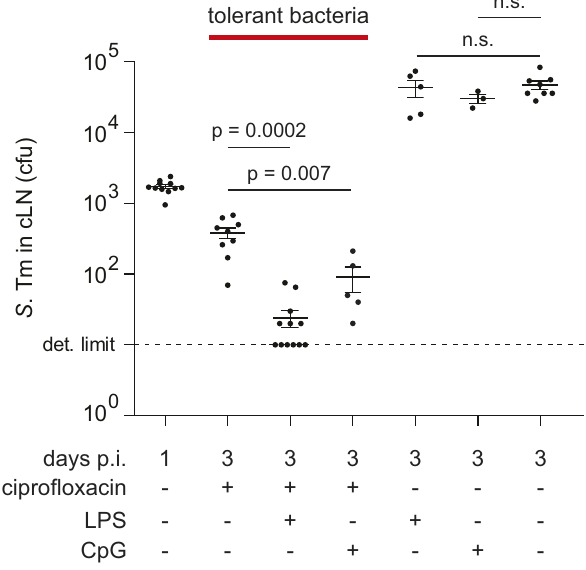
Figure 6. LPS or CpG treatment reduces the number of ciprofloxacin-tolerant bacteria in the cLN. C57BL/6 mice were infected for 1 d or 3 d with wt S. Tm (5 6 10 7 cfu by gavage). Ciprofloxacin treatment (2 6 62 mg/kg/d) was started at day 1 p.i. and continued until the end of the experiment, as indicated. The indicated groups were treated with a single dose of LPS (5 m g intraperitoneally) or CpG (100 m g intraperitoneally) at day 2 p.i. Cfus in the cLN were analyzed by plating. For gut content and spleen loads, see Figure S14. Each symbol represents one mouse. Dashed line, detection limit. p , nonparametric statistical analysis (Mann–Whitney U test). n.s., not significant.